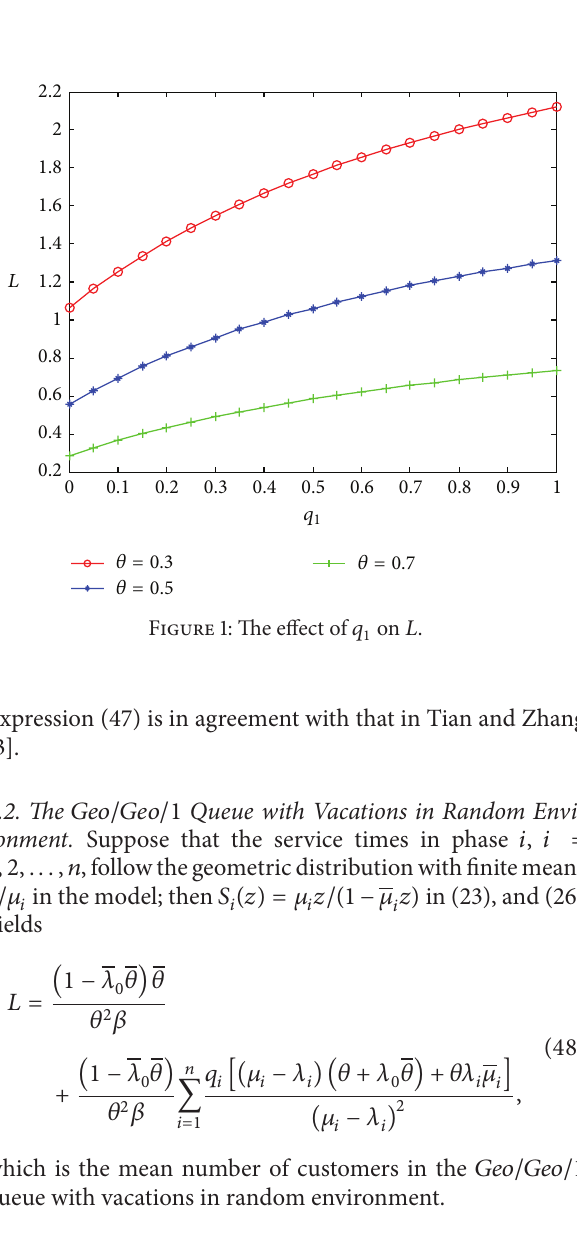
Figure 3: The effect of 𝜆 0 on 𝑃 0,0